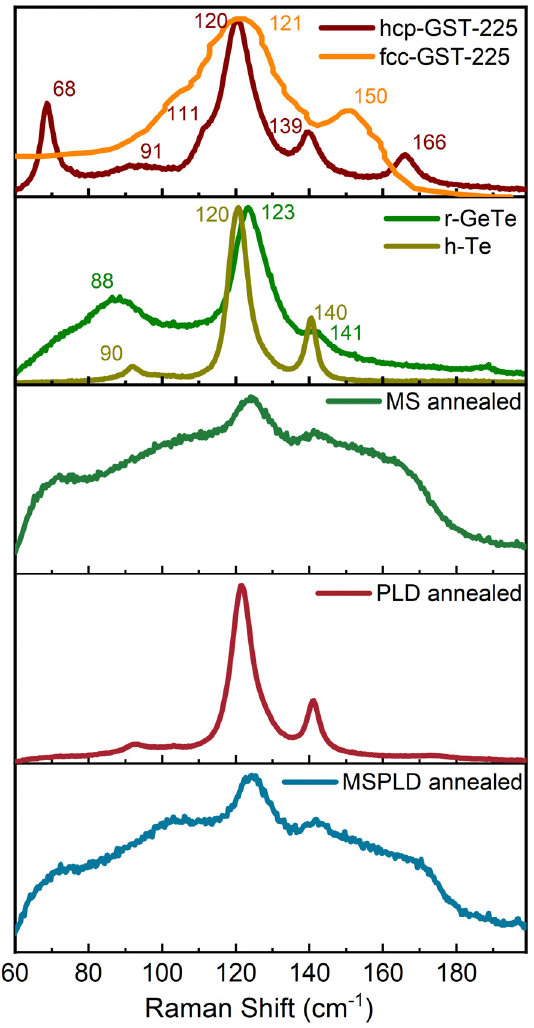
Figure 2. Raman spectra obtained on MS, PLD and combined MSPLD samples. fcc-GST-225 [34], hcp-GST-225, r-GeTe and h-Te were also added for comparison.